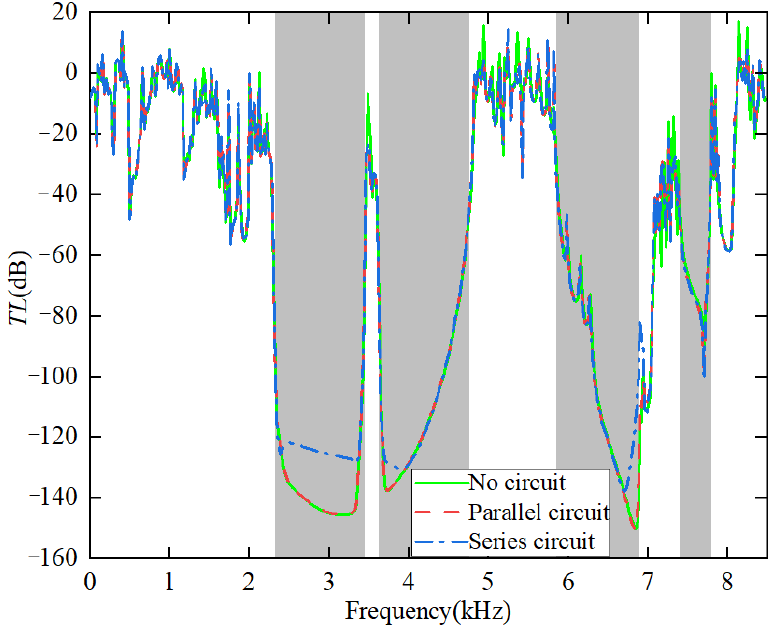
Figure 9. Transmission loss of the finite length piezoelectric phononic crystal. Figure 10a, b show the band structure and attenuation constant in the MΓ direction.